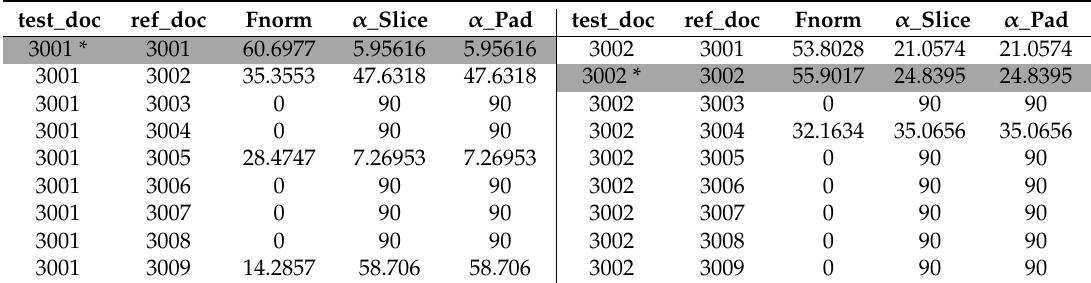
Table 1. Example of the feature value extracted after the LSA process for test documents no #3001 and